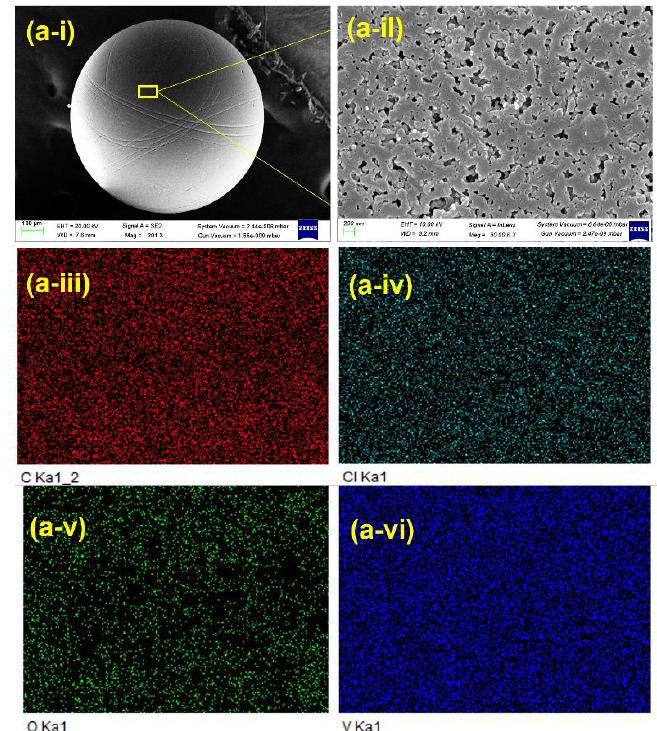
[V IV O(acac)L 1 ]@PS ( 3 ).